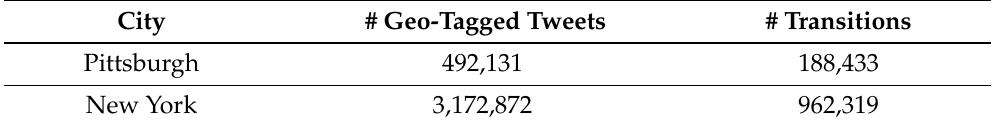
Table 1. Number of tweets and transitions in two urban cities, where a transition is a movement by the same user from one area to another area within a predefined time interval ∆ t